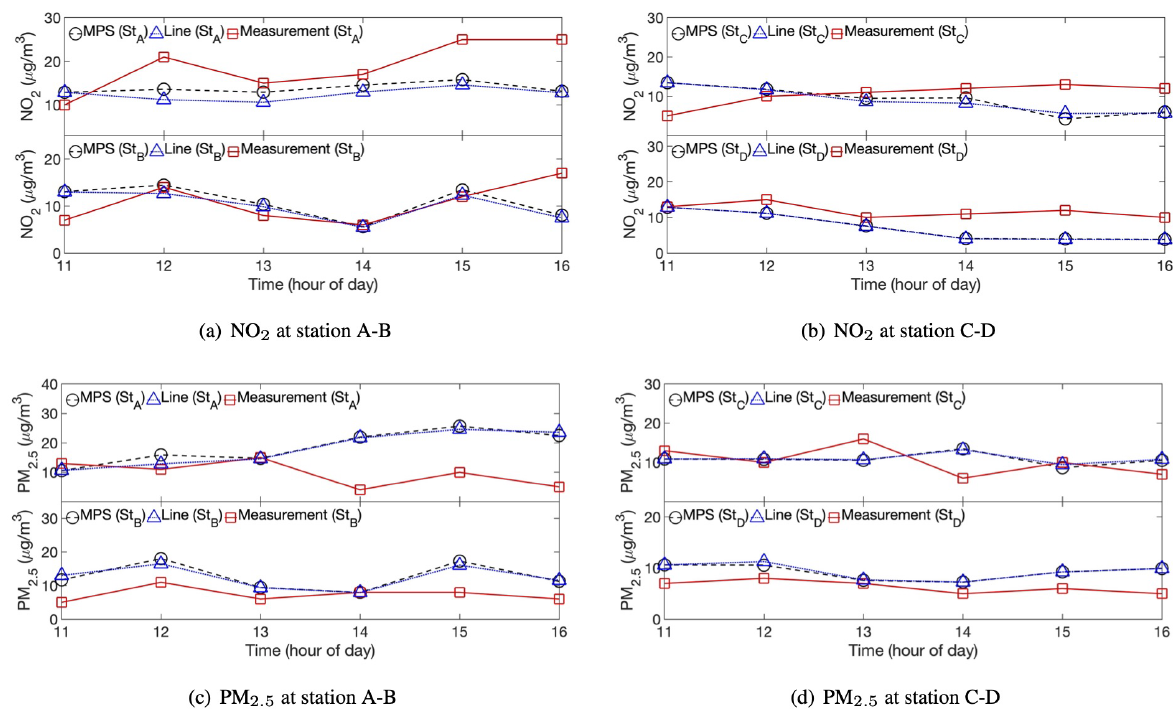
Figure 17. Comparison of hourly averaged emission concentrations between simulation and measurement at different